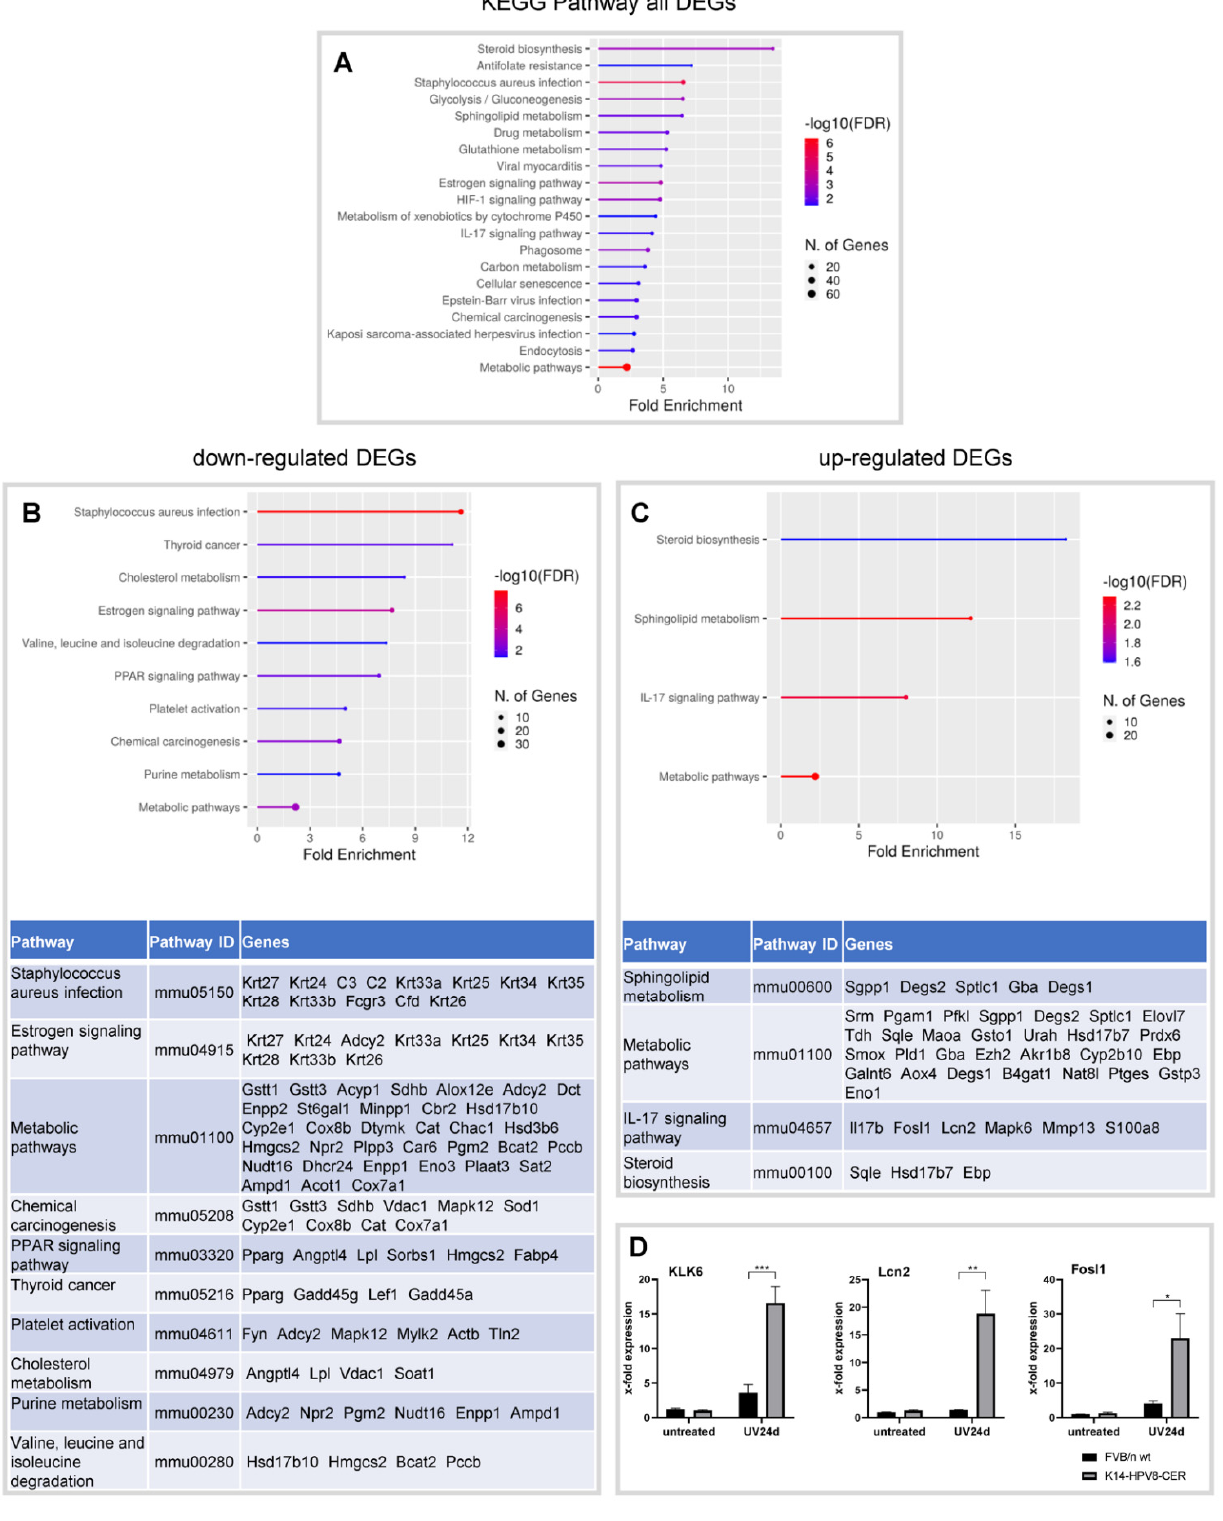
Figure 2. KEGG enrichment analysis for DEGs in skin tumours of K14-HPV8-CER mice. ( A ) KEGG enrichment analysis for all DEGs; KEGG enrichment analysis for only ( B ) downregulated and ( C ) upregulated DEGs. ( D ) KLK6, Lnc2 and Fosl1 mRNA expression is enhanced in UV-induced skin tumours in K14-HPV8-CER mice. Statistical analysis was generated with Student’s t -test with * p < 0.05, ** p < 0.01 and *** p < 0.001.